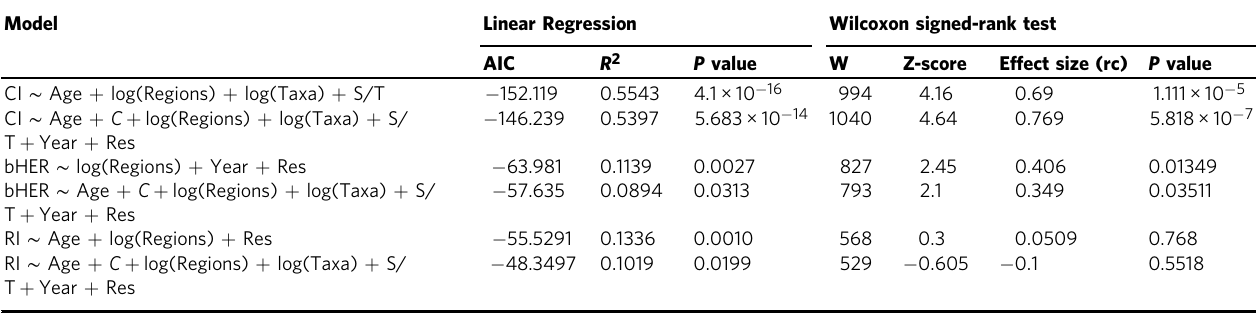
Table 2 Biogeographic congruence metrics modelled by potential confounding variables. Model Linear